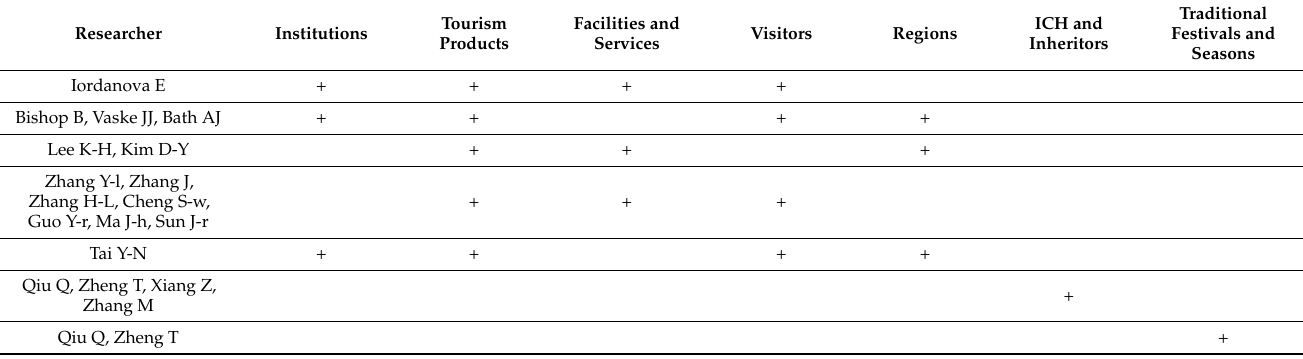
Table 3. Comparison of cognitive elements extracted from previous literature and